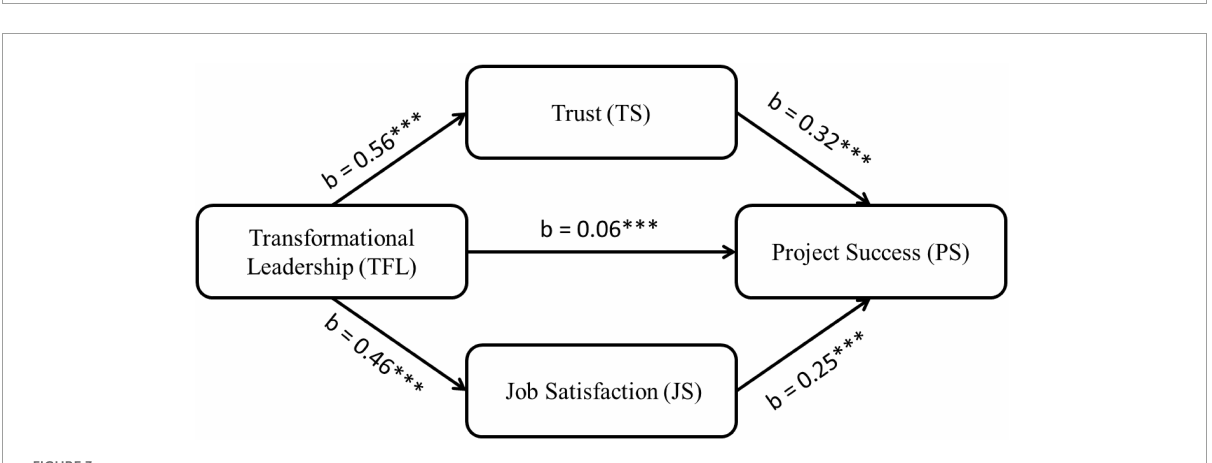
FIGURE3 Model 2. X 2 /df = 1.93, p < 0.001, RMSEA = 0.031, GFI = 0.969, CFI = 0.971, TFI = 0.968. * p < 0.05, ** p < 0.01, *** p <